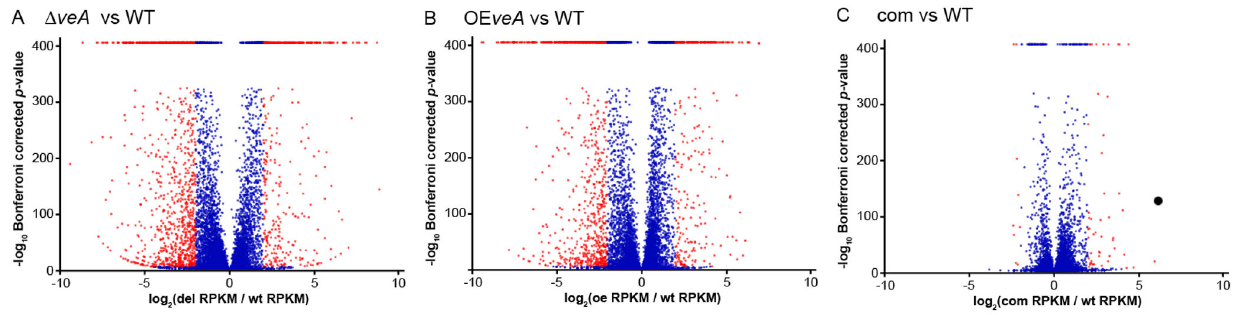
Figure 1. Differentially regulated genes in comparisons of veA deletion, overexpression and complementation strains against the wild-type strain. For each gene, the log rRPKM is reported along the x-axis and the negative log of the Bonferroni- 2 10 corrected Fisher’s Exact p -value is reported along the y-axis. P -values with an infinite log value ( p -values equal to zero) are 10 reported as 400. Genes with a log rRPKM greater than 2 and a Bonferroni-corrected p -value less than 0.05 are considered 2 differentially regulated and are represented by red dots, whereas genes below these thresholds are not considered to be differentially regulated and are represented by blue dots. (A) Comparison between the strain that carries a deletion of the veA gene (∆ veA ) and the wild-type (WT) strain; (B) Comparison between the veA over-expression strain (OE veA ) and the WT strain; (C) Comparison between the veA complementation strain (com) and the WT